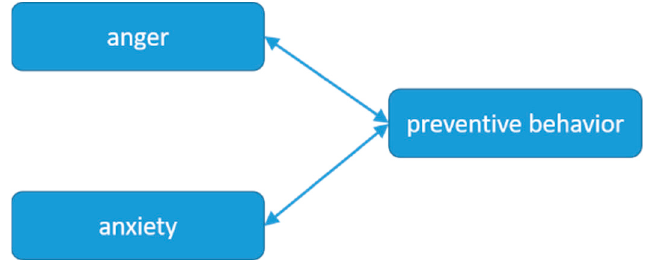
Figure 3. Causal channels of emotions and preventive behavior.